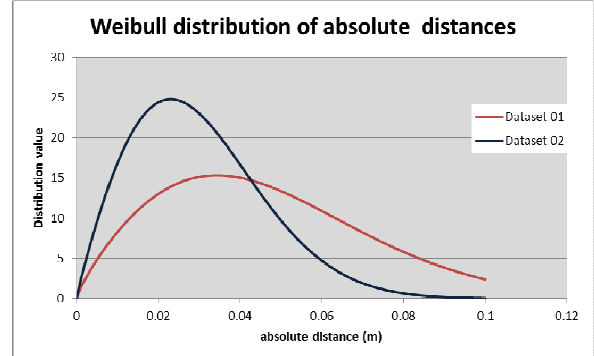
Figure 13: Weibull distribution of absolute distances between the photogrammetric point clouds and the TLS one. Project made from precalibrated camera.